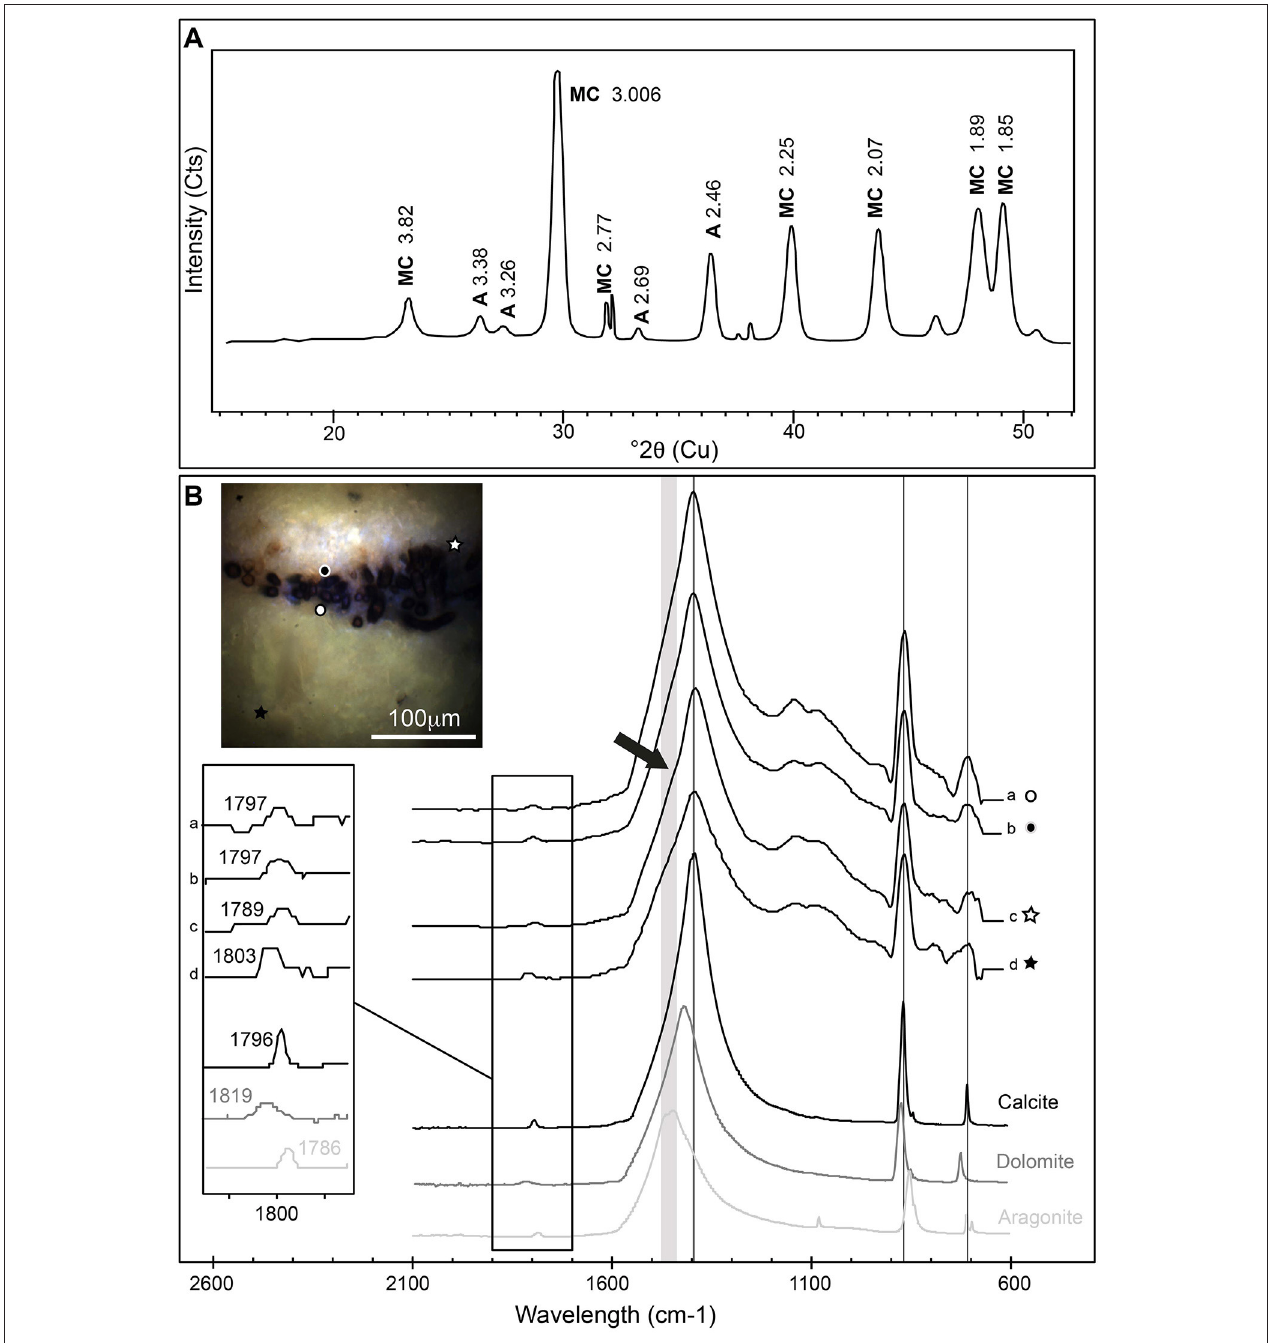
FIGURE 10 | (A) X-ray powder diffractogram obtained on a Rivularia -rich lamination. It shows Mg-rich calcite (MC) and aragonite (A) (Cts stands for counts). (B) ATR-FTIR spectra obtained on a Rivularia -rich lamination from a cross section of an oncoid associated with a black pustular mat also analyzed by S-DUV ( Figure 9B ). The precise localization of the spectra is given in the associated full-field RGB fluorescence emission image (white and black circles and stars). ATR-FTIR spectra were compared to standard spectra of calcite, aragonite and dolomite (Rruff database; http://rruff.info/) and showed the predominance of calcite mixed with either a Mg-carbonate or aragonite, detected by the shift of the CO 3 2 − vibration bands at 1,796 cm − 1 and a shoulder on the CO 3 2 − asymmetric stretching band around 1,400 cm − 1 (black arrow).